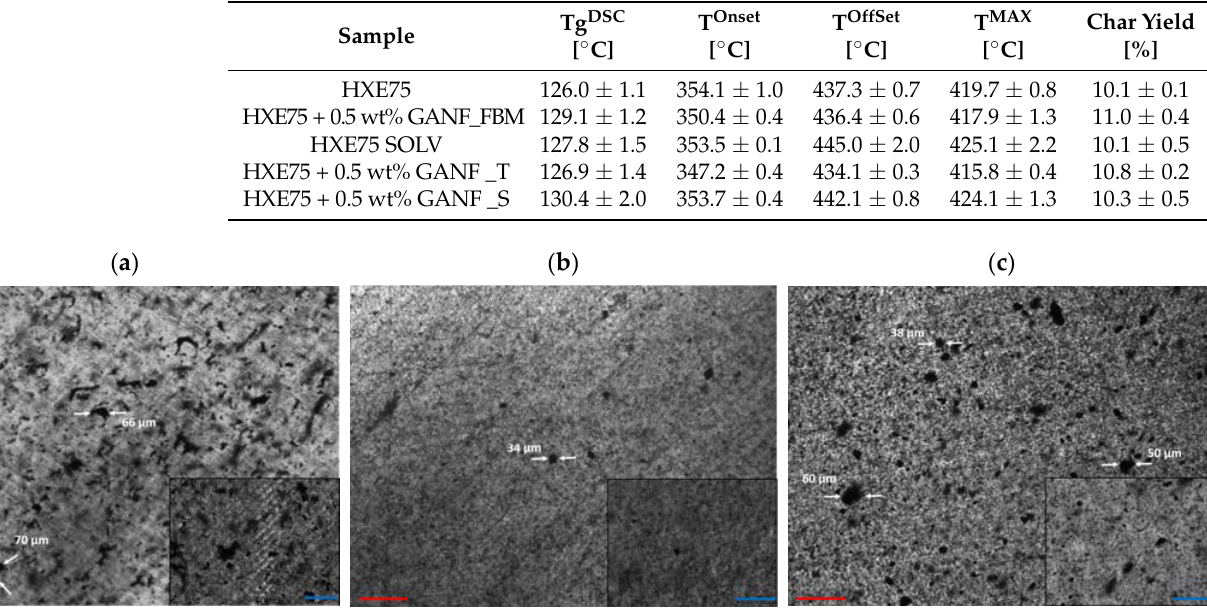
Table 4. Results of the thermal characterization (DSC and TGA) of the GANF based nanocomposites. Sample